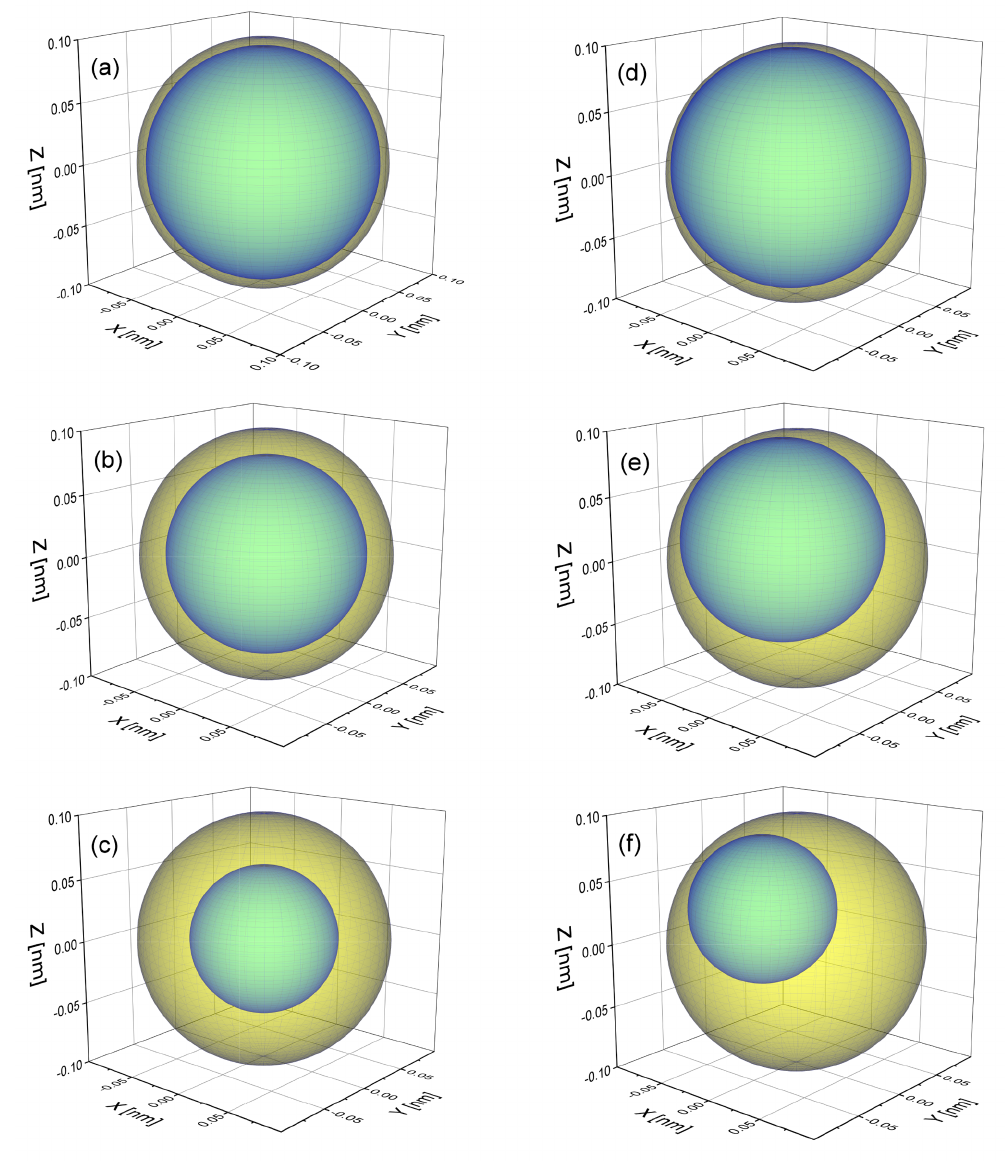
Figure 1. Schematic of a phase-separated particle with a 100nm radius to illustrate the thickness of the organic shell at (a) OIR = 1 : 4, (b) OIR = 1 : 1 and (c) OIR = 4 : 1 for concentric core-shell morphologies. Panels (d–f) are the same for a single realization of an eccentric core-shell morphology. The calculations in this work typically use 500 such realizations, randomly oriented (with different distances of the inclusion from the center of the particles and different azimuth and polar angles). The direction of incoming light is along the z